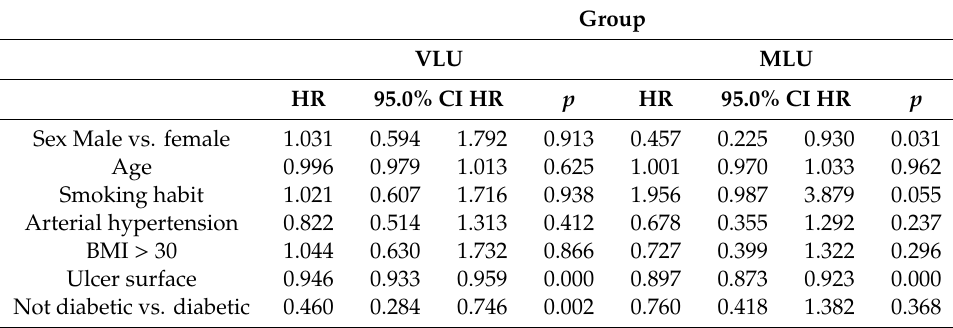
Table 2. Multivariate Cox model analysis.